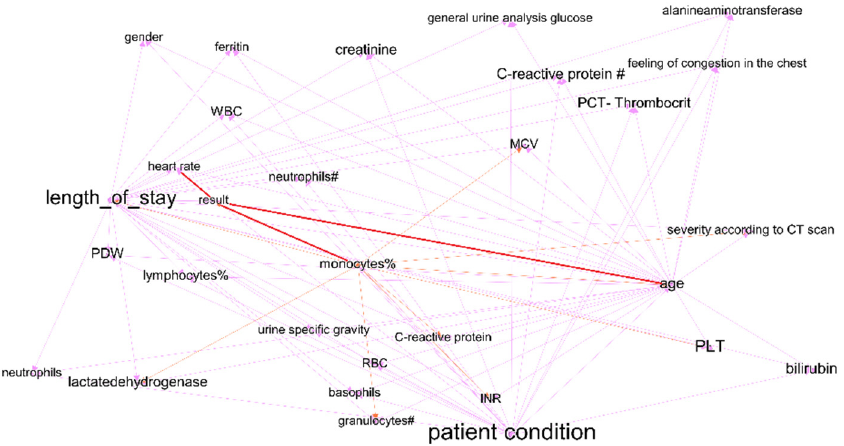
Figure 5. Cluster from DAG for the first-time interval, which includes the variable length of stay and treatment outcomes.